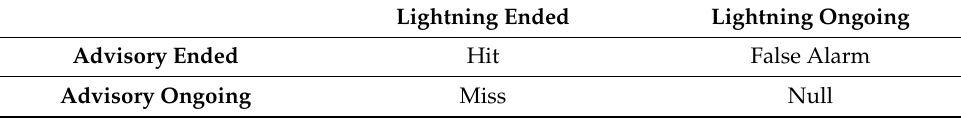
Table 1. A 2 × 2 contingency table used to calculate skill scores for each cessation algorithm. Lightning Ended Lightning Ongoing Advisory Ended Hit False Alarm Advisory Ongoing Miss